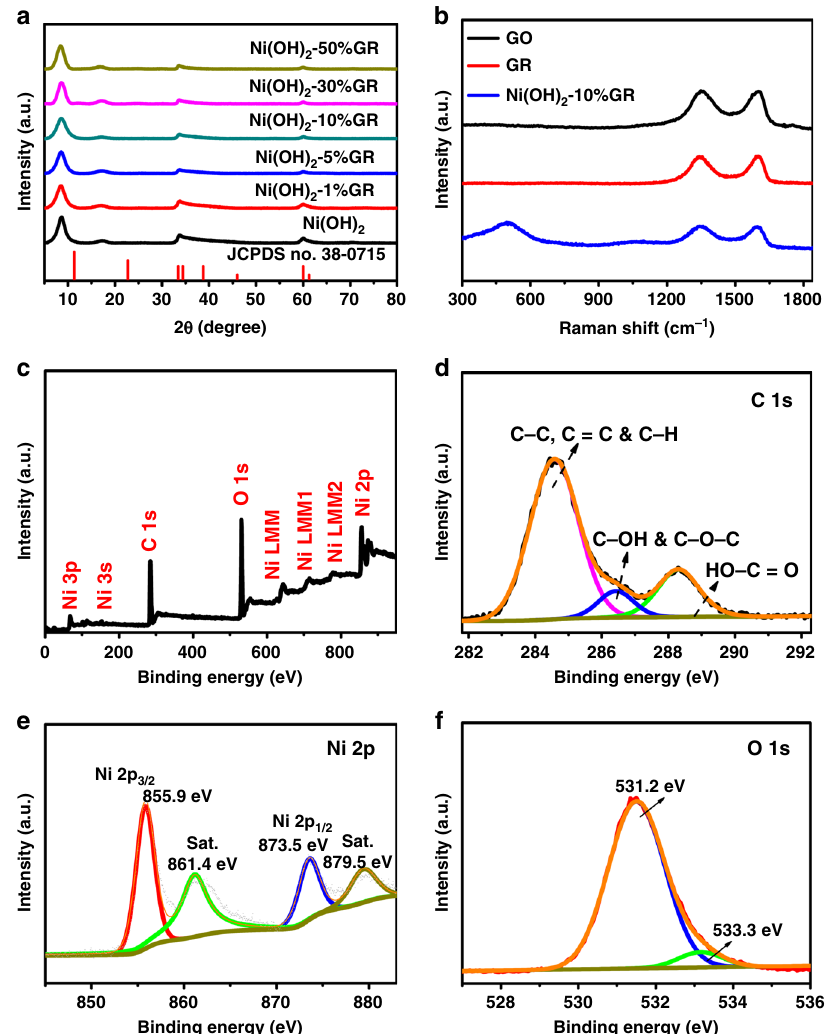
Fig. 2 Structure characterization of Ni(OH) 2 -10%GR. a XRD patterns of Ni(OH) 2 -GR composite with different GR contents and bare Ni(OH) 2 . b Raman spectra of GO, GR and Ni(OH) 2 -10%GR. c XPS survey spectrum, high-resolution XPS spectra of d C 1 s, e Ni 2p, and f O 1 s of Ni(OH) 2